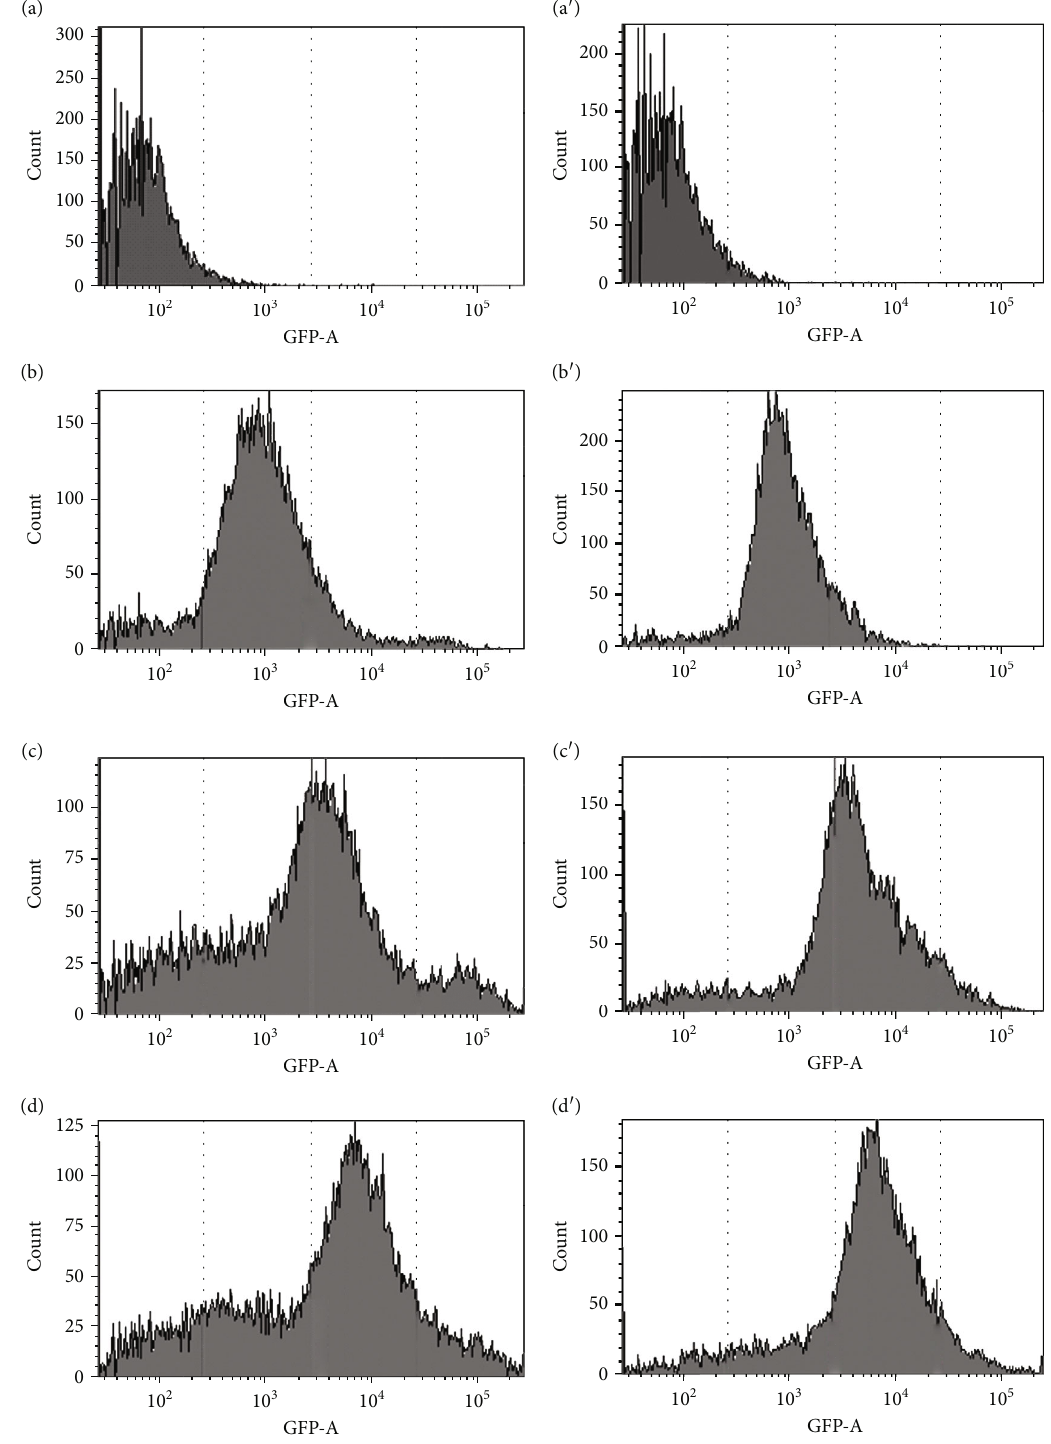
Figure 4: Intracellular incorporation of FITC-labelled HSA ((a) original fl uorescence of HeLa cells, (b) 5 μ M, (c) 50 μ M, and (d) 100 μ M) or FITC-labelled CT – HSA ((a ′ ) original fl uorescence of HeLa cells, (b ′ ) 5 μ M, (c ′ ) 50 μ M, and (d ′ ) 100 μ M). The data were obtained using a fl ow cytometric